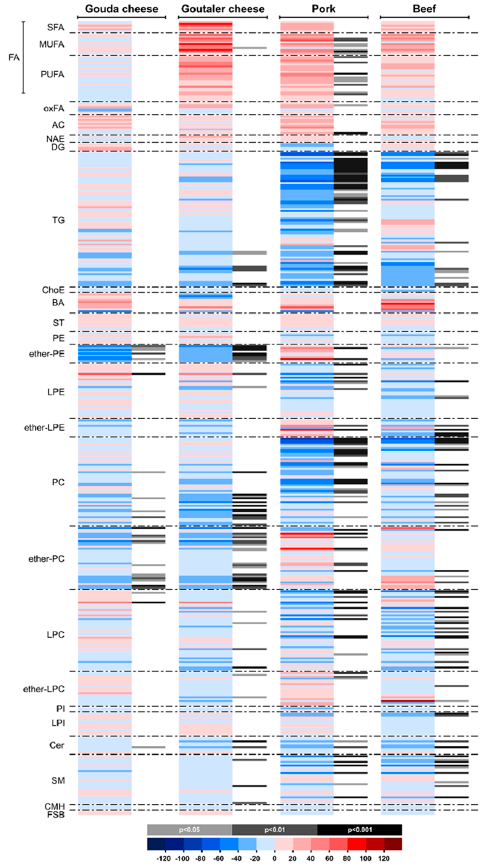
Figure 2. Heatmap representing the results of the lipidomics analysis for the four test diets (Gouda and Goutaler-type cheeses, pork, and beef). Data are represented as median ± SD of the percentage of change (post- versus pre-intervention values) (adjusted Wilcoxon signed-rank test, Holm–Sidak method). Abbreviations: fatty acids (FAs); saturated FAs (SFAs); monounsaturated FAs (MUFAs);